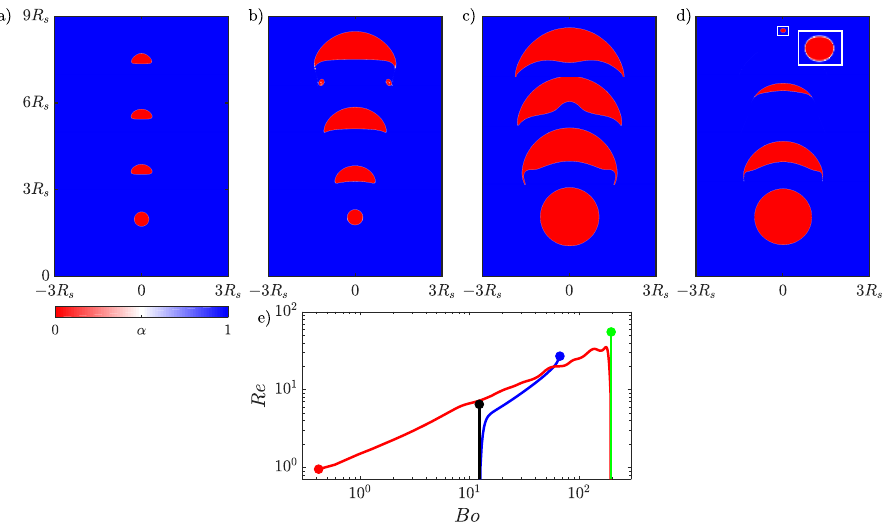
Figure 8. Evolution of an initially small rising bubble in ( a ) a non-reactive flow evolving into an ellipsoidal bubble and ( b ) the same initial bubble in a reactive flow growing into a skirted bubble. A larger rising bubble in ( c ) a non-reactive flow that becomes a skirted bubble and ( d ) the same initial bubble in a reactive flow shrinking to form a spherical bubble. Four time instances are shown for each bubble, and the dimensions of all four panels are based on the initial radius R s of the larger bubble. An inset is included in ( d ) to enlarge the final state of the rising bubble. ( e ) The time evolution of the Re and Bo of the rising small bubble in non-reactive flow (black), small growing bubble (blue), large bubble in non-reactive flow (green), and large shrinking bubble